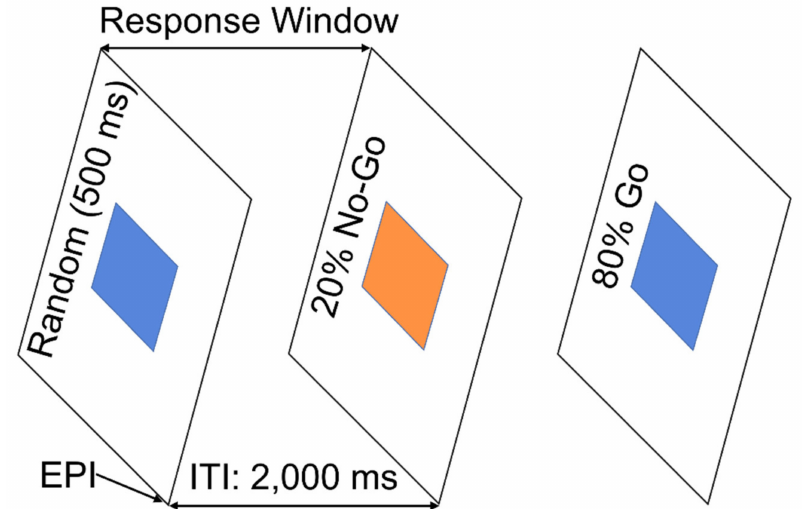
Figure 1. Schematic diagram illustrating the Go/NoGo